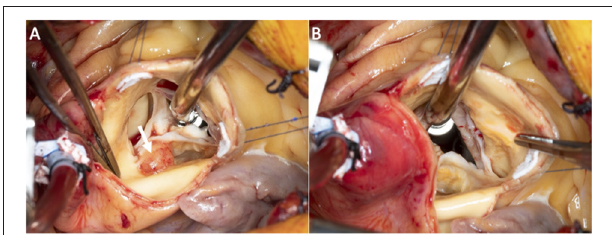
FIGURE 4 | Superior intra-operative images of the aortic valve with the valve closed (A) and opened (B) .